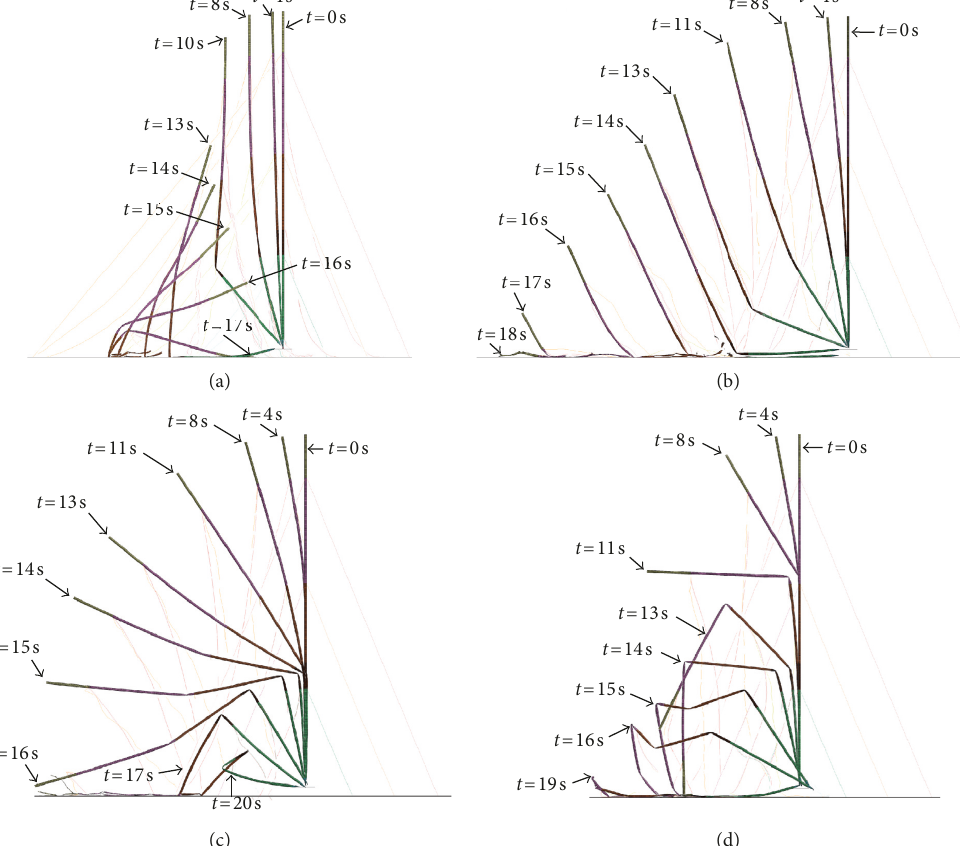
Figure 7: Types of fall regimes: (a) Regime A, (b) Regime B, (c) Regime C, and (d) Regime D.